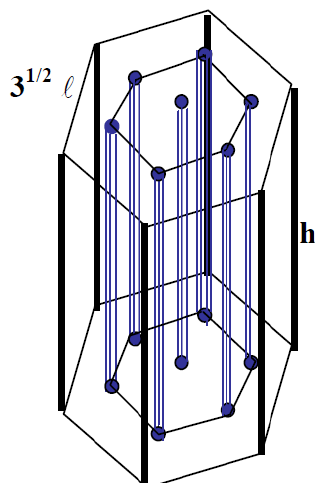
Figure 7. Hexagonal prismatic RVE.